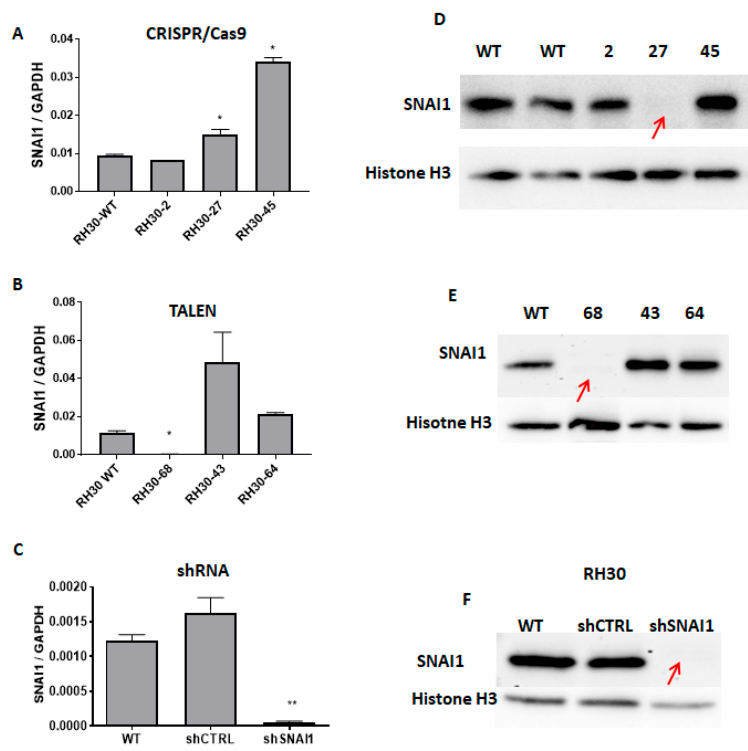
Figure 3. SNAI1 expression levels after modifications with TALEN, CRISPR / Cas9 nucleases, and shRNA. ( A ) SNAI1 mRNA expression levels in RH30 clones after CRISPR / Cas9 cleavage (qPCR). The data were calculated as a relative expression of SNAI1 to GAPDH using the ∆ CT method (n = 2–3). ( B ) SNAI1 expression levels in RH30 clones after TALEN cleavage (qPCR). A significant reduction of